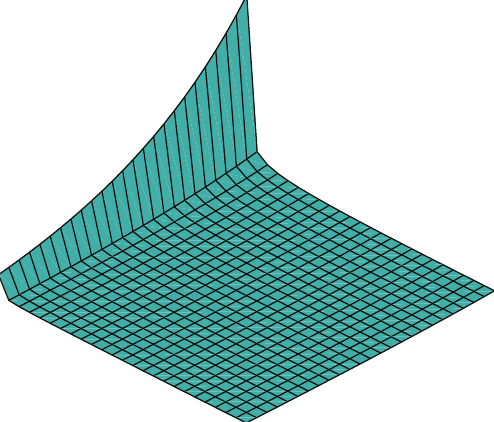
Figure 2: Plot of solution (79) with 𝑐 1 = 0 , 𝛾 = 𝑐 2 = 1